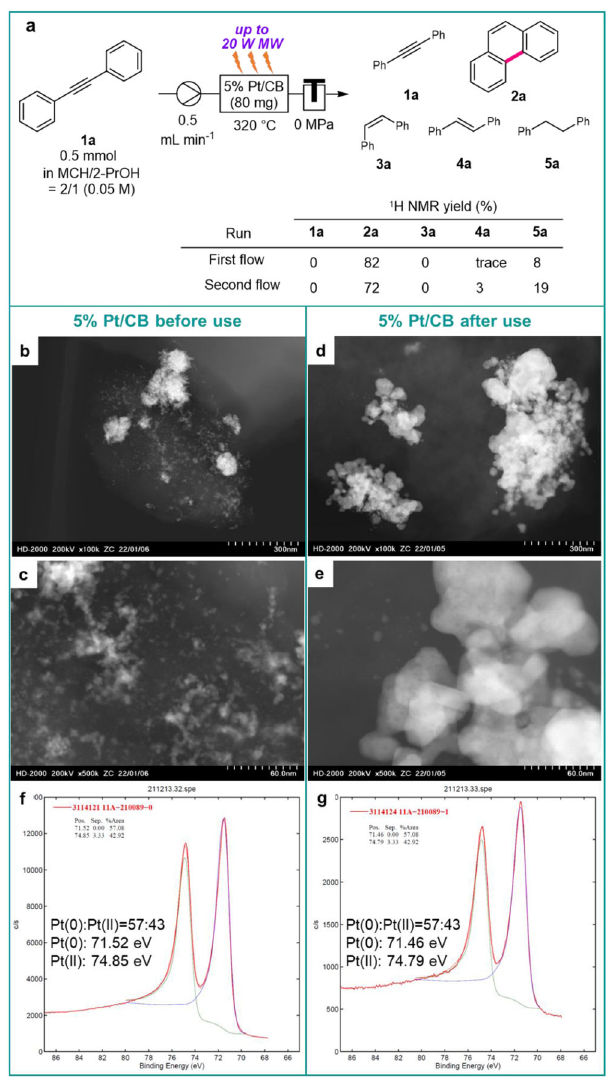
Fig. 7 Reuse test of 5% Pt/CB. a The reuse test of 5% Pt/CB under MW- assisted C – C bond formation reaction using 1a as a starting material. b – e STEM image of 5% Pt/CB before and after use. f , g XPS spectra of 5% Pt/CB before and after